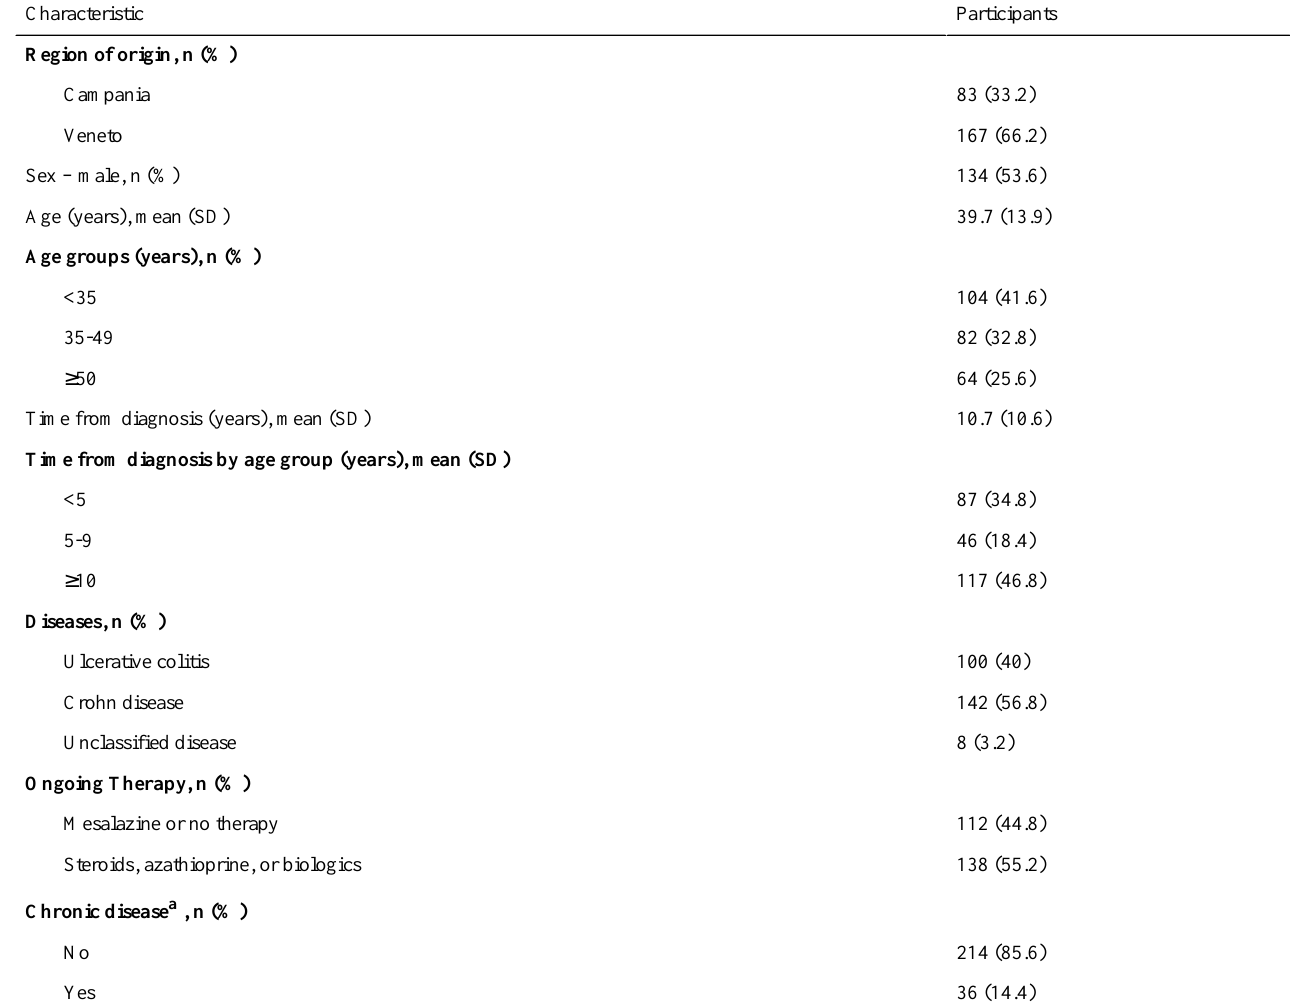
Table 1. Study population characteristics